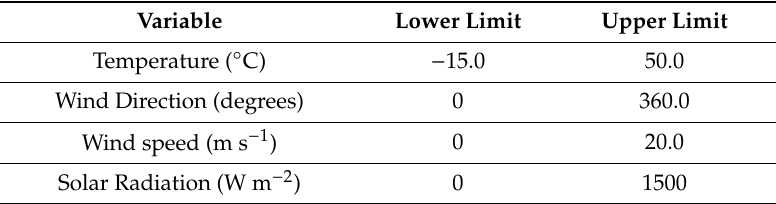
Table 3. Upper and lower limits for the automated range